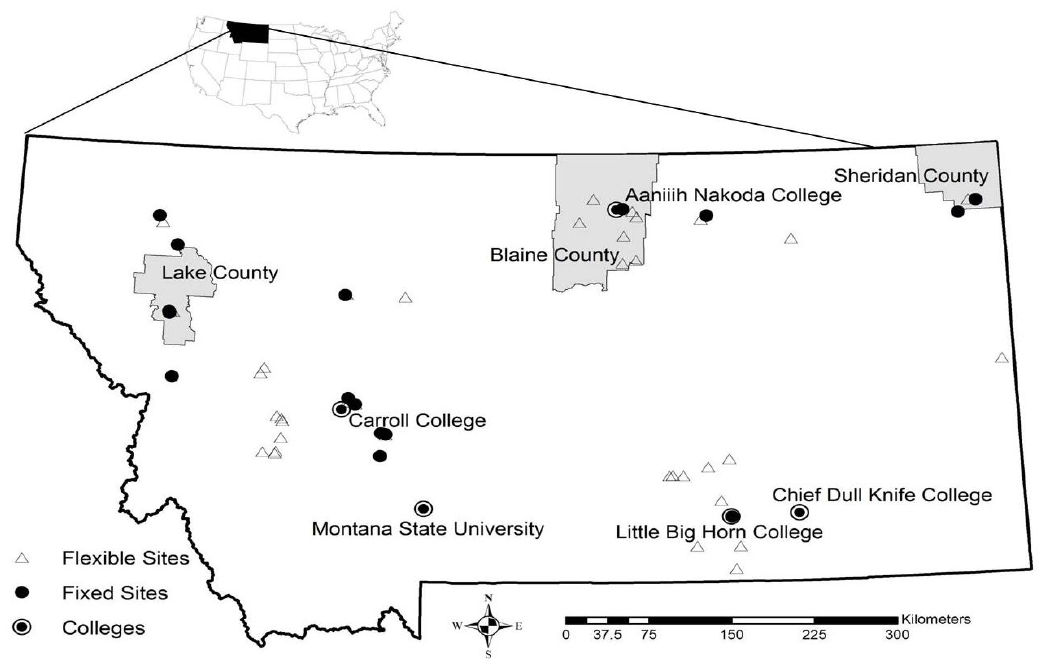
Figure 1. Fixed and flexible surveillance locations for 2009–2012. Fixed sites were trapped ≥10 times during the 10-week period from the third week in June through August. Flexible sites were trapped fewer than 10 times or only in some years as funding